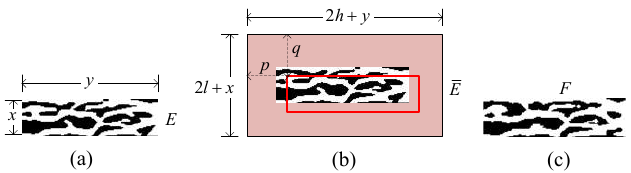
Figure 1. Matching sample. ( a ) a finger-vein template; ( b ) the extended image from ( a ); ( c ) a testing image. The values in pink region are − 1 in ( b ). The red rectangle box translates in the extended images from top left corner to lower right corner.